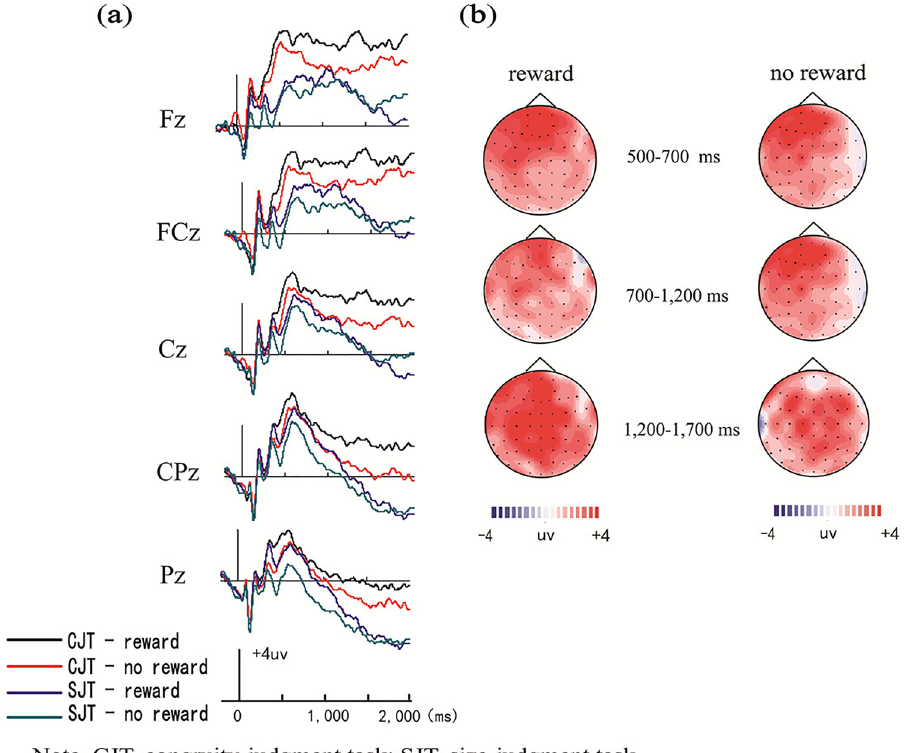
Figure 3. Amplitude distribution and topographic maps of ERPs in the different conditions in the study phase. ( a ) Comparison of ERP amplitudes in the four conditions. ( b ) Topographic maps of encoding effects ERPs (congruity-judgment task minus size-judgment task) both in reward and no-reward conditions.